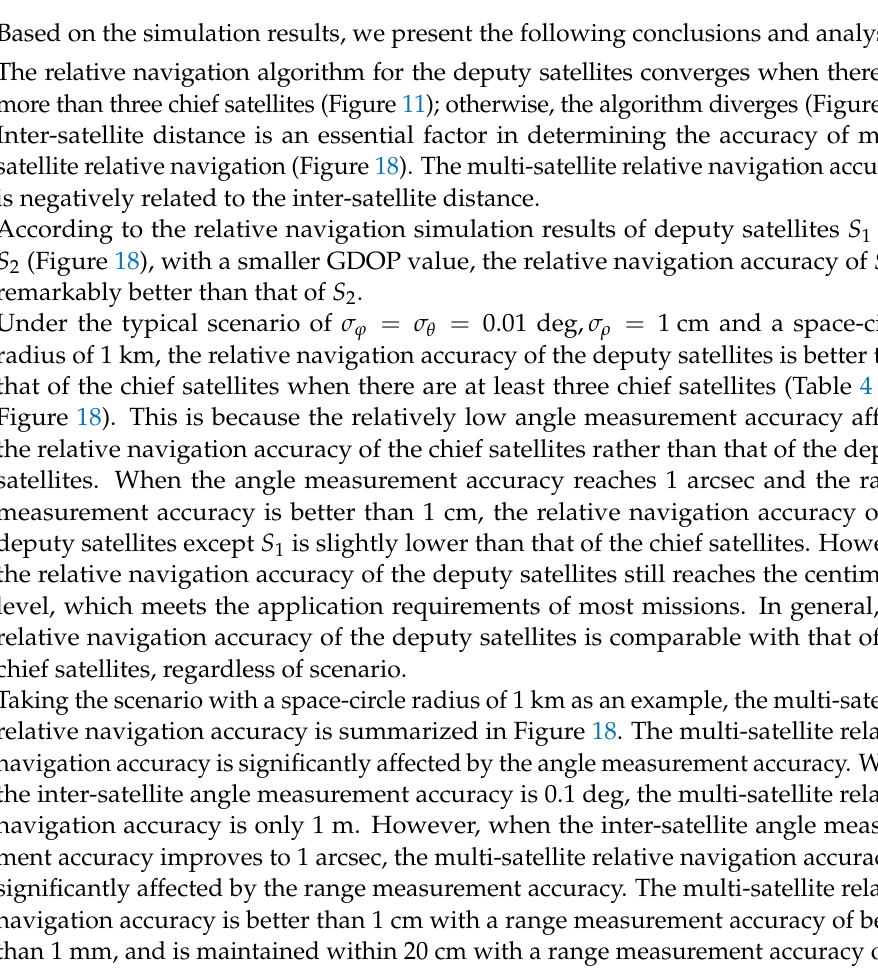
Figure 17. Relative navigation errors of 𝑆 1 (simulated scenario: Case e, space-circle formation radius 1 km). To assess the effect of the inter-satellite measurement accuracy, inter-satellite dis- tance, GDOP value, and number of chief satellites on the relative navigation accuracy, simulations were also conducted under the scenarios summarized in Table 5. Statistical results for the relative navigation accuracy are displayed in Figure 18. Table 5. Simulation scenarios and simulation parameters.